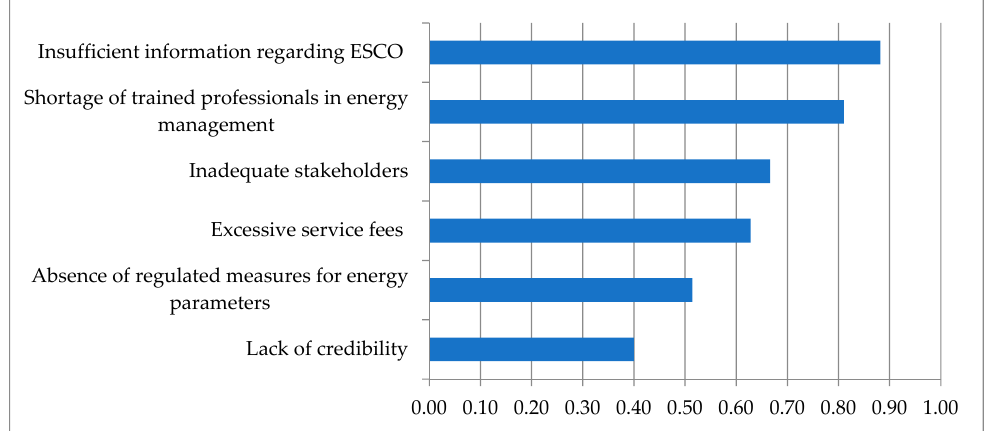
Figure 9. The perceived barriers for consulting with energy service companies.